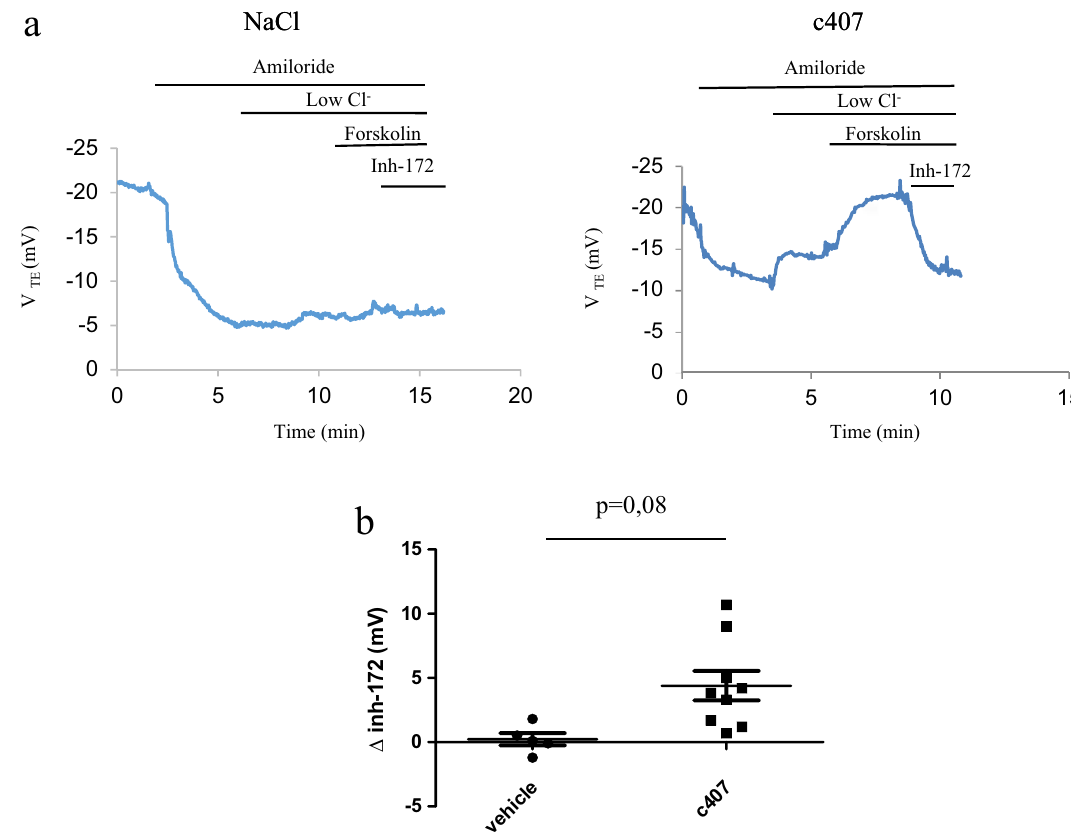
Figure 2. Effects of intraperitoneal administration on Nasal Potential Difference in F508del Cftr tm1Eur mice. ( a ) Tracing of Nasal Potential Difference performed in a F508del Cftr tm1Eur mouse after